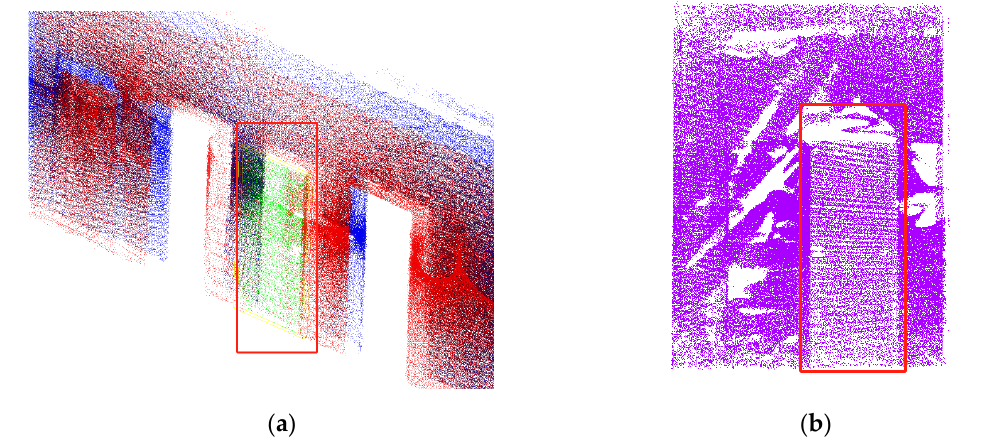
Figure 17. Doors with different geometric features. ( a ) Thick door ( b ) Thin